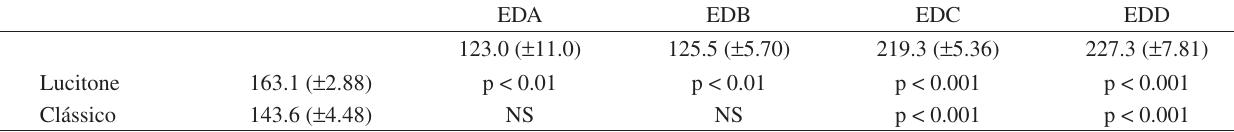
Table 1. Impact resistance (J.m –1 ). Comparison of commercial materials and ground experimental materials (1-way ANOVA and Bonferroni’s test - p < 0.05).